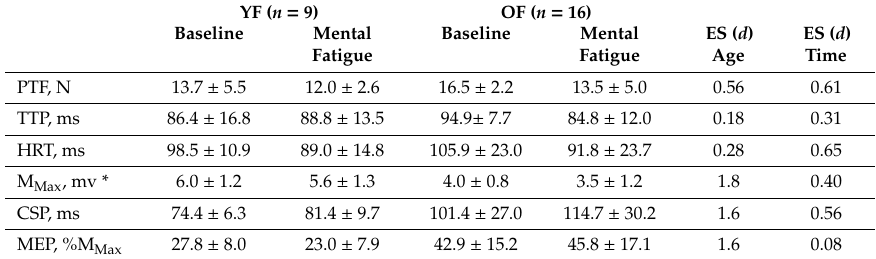
Figure 2. Baseline (BL) and mental fatigue (MF) maximal voluntary contraction (MVC) force values. ( A ) There was a significant decrease ( p = 0.02) in MVC with MF. ( B ) MVC force after MF protocol. Data presented as percent of BL MVC after MF. Table 2. Neuromuscular measures before and after mental fatigue. Table 2. Neuromuscular measures before and after mental